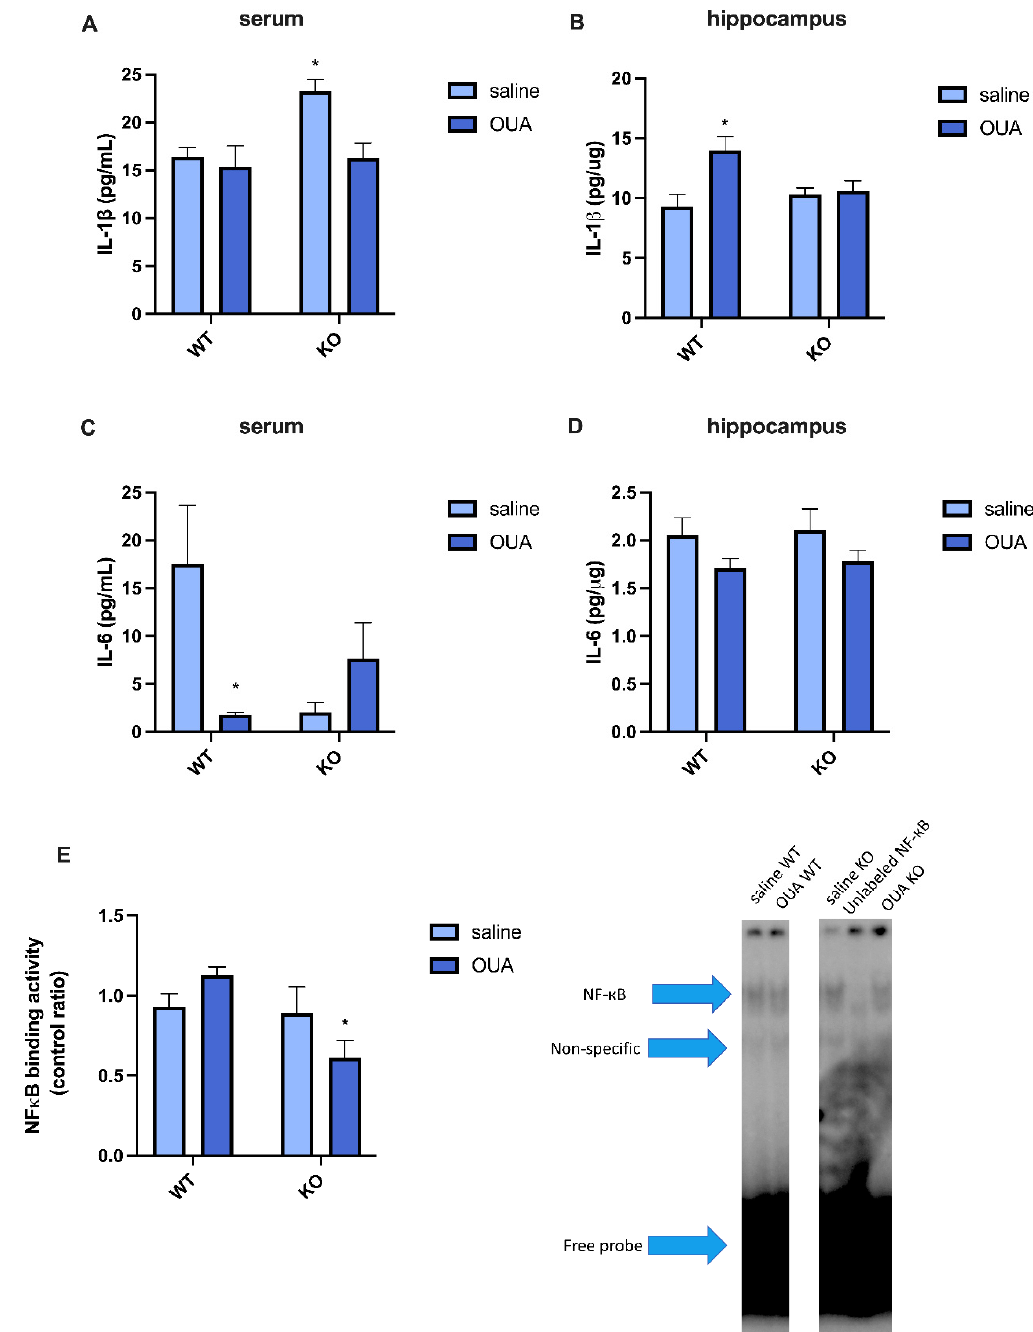
Figure 2. TNFR1 KO mice respond differently to ouabain in comparison to WT mice. ( A ) Basal levels of IL-1 β in serum are higher in TNFR1 KO in contrast with the other groups, * vs. saline WT, OUA WT, and OUA KO (* p < 0.05). ( B ) Ouabain increases hippocampal IL-1 β levels in WT mice, * vs. saline WT (* p < 0.05). ( C ) Ouabain reduces the basal serum levels of IL-6 only in WT mice, * vs saline WT (* p < 0.05). ( D ) No changes were found in the IL-6 response in the hippocampus. ( E ) Densitometric analysis and representative EMSA of NF- к B binding activity showed that ouabain causes different responses in NF- к B activity according to the presence or not of TNFR1. Ouabain decreases the NF- к B activity in TNFR1 KO mice, * vs OUA WT (* p < 0.05). Results are expressed in pg/mL for serum samples, pg/ υ g (mean ± SEM), or NF- к B binding activity (control ratio) in the hippocampus ( n = 4, N = 2, only IL-1 β in the hippocampus has three individual experiments). Two-way ANOVA followed by Tukey’s post-test.